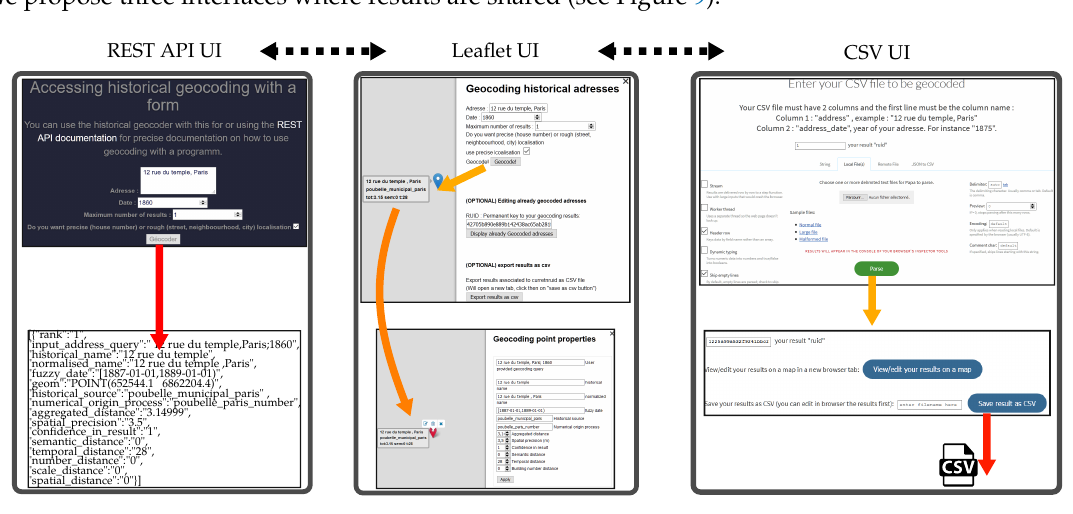
Figure 9. Various Web user interfaces (UIs) that can be used to access the proposed historical geocoding tool. CSV: comma-separated